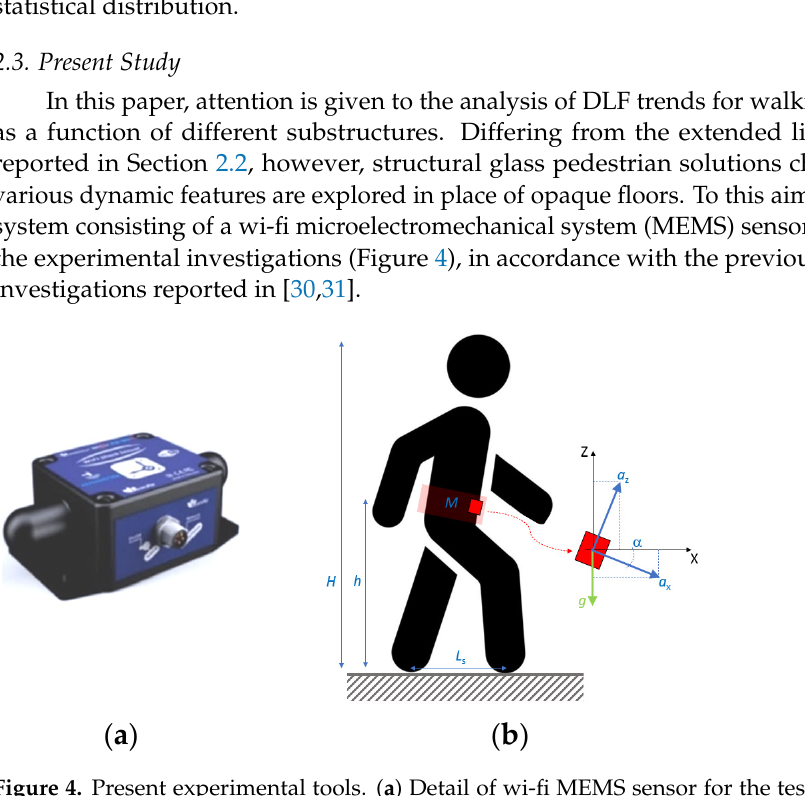
Figure 4. Present experimental tools. ( a ) Detail of wi-fi MEMS sensor for the tests. ( b ) Schematic setup for the measure of body CoM motion records.